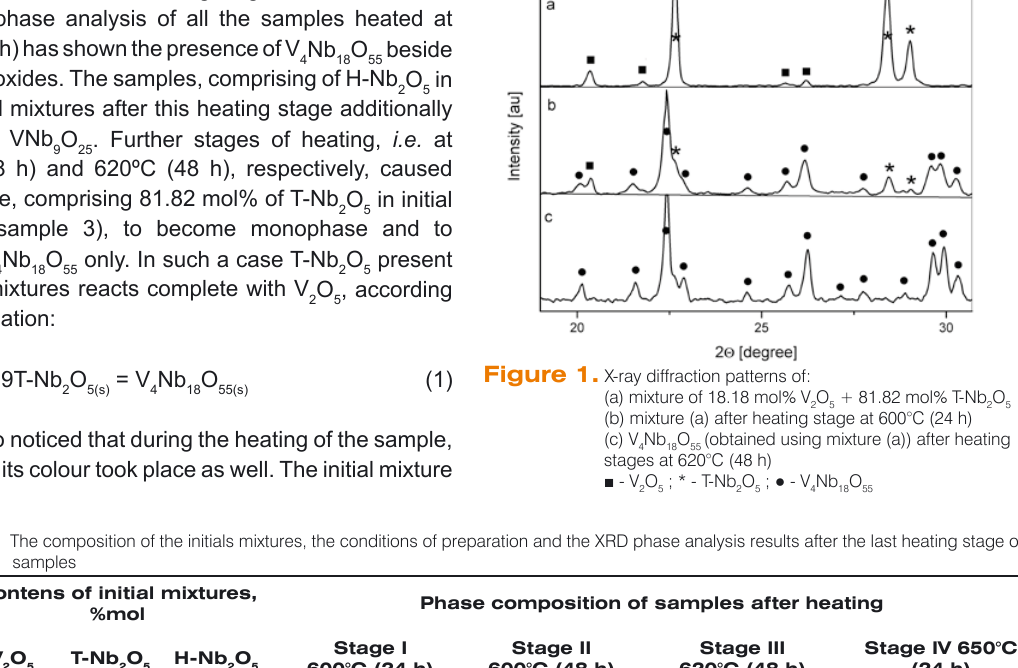
Table 1. The composition of the initials mixtures, the conditions of preparation and the XRD phase analysis results after the last heating stage of samples